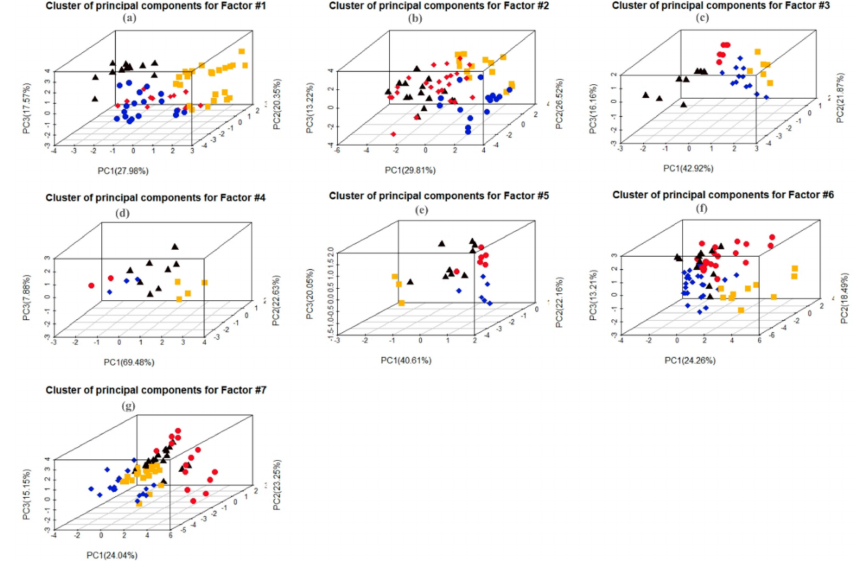
Figure A2. A cluster based on individual basin experts’ country of origin, in which black triangles are Egyptian, yellow rectangles are Ethiopians, red circles are equatorial states, and blue diamonds are Sudanese, where ( a ) is experts response division on indicator under factor-#1 called natural features, ( b ) factor-#2—socioeconomic needs of basin states, ( c ) factor-#3—the population dependent on the watercourse, ( d ) factor-#4—the e ff ects of water use, ( e )factor-#5—existing and potential uses, ( f ) factor-#6—costs of conservation and protection, and ( g ) factor-#7—availability of alternative and comparable